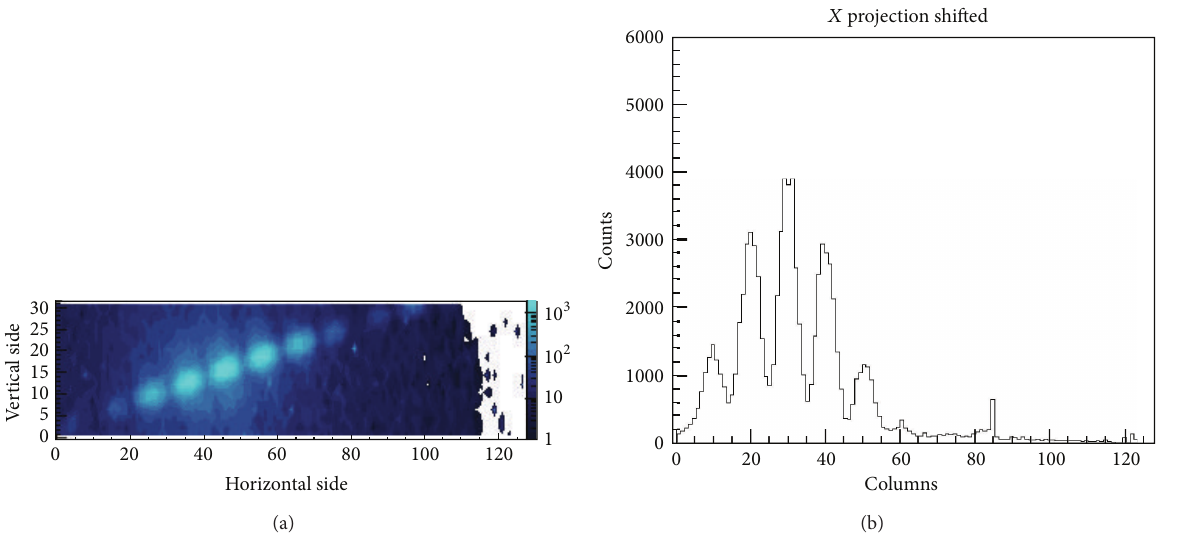
Figure 35: Interference scatter plot obtained by adding-up the stack of frames (a) and its projection along the vertical axis (b).